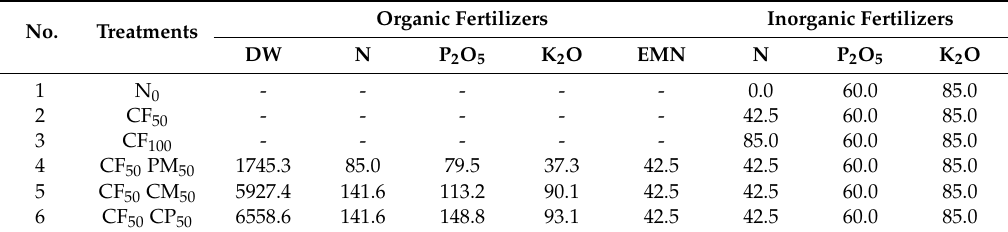
Table 1. Weight and nitrogen (N), phosphorus (P) and potassium (K) applied (kg ha − 1 ) from organic and inorganic